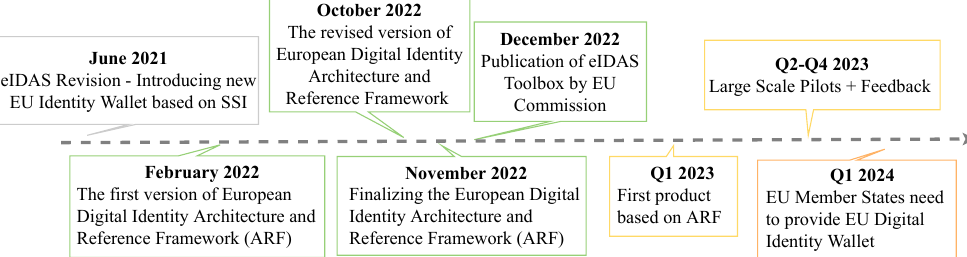
Figure 8. Timeline of new eIDAS 2.0 regulation adoption by